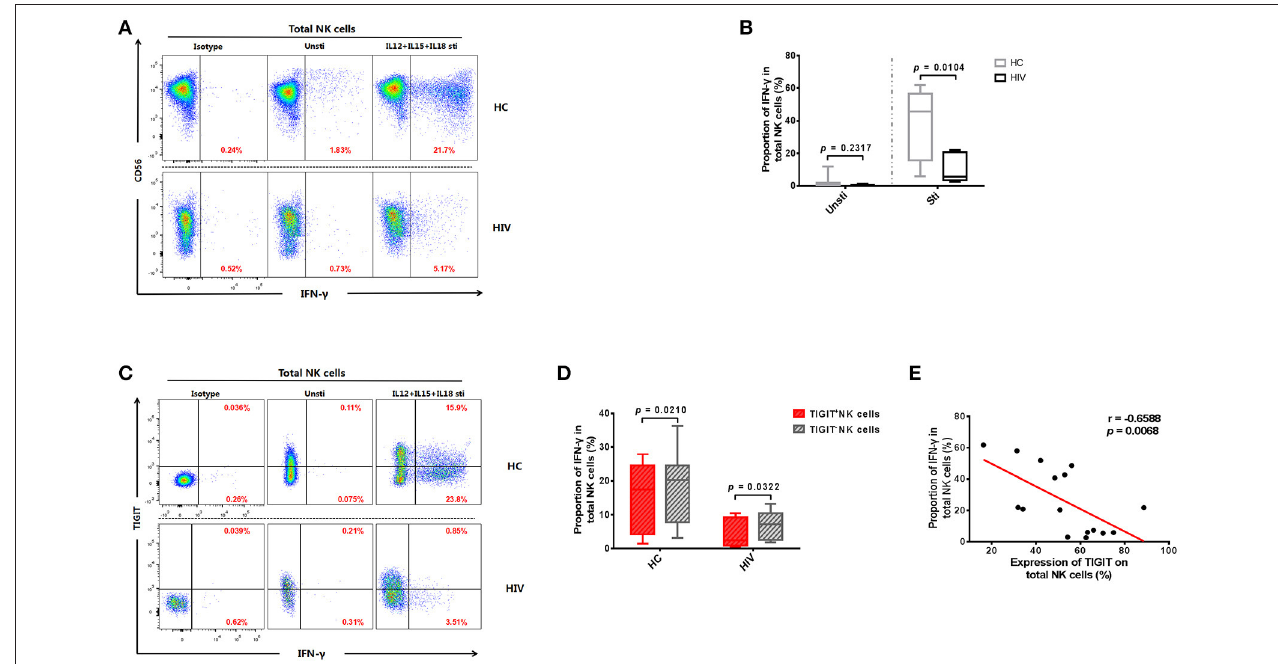
FIGURE 2 | Expression of TIGIT limits the production of IFN- γ by NK cells. (A) A representative flow cytometry plot showing the different percentages of IFN- γ producing NK cells after stimulation with rIL-12 + rIL-15 + rIL-18 for 24h in HC and HIV-infected individuals. The IFN- γ expression was gated according to an isotype control. (B) Comparison of the function of NK cells from HIV-infected ( n = 8) and HC ( n = 8) groups, based on their IFN- γ production on stimulation with rIL-12 + rIL-15 + rIL-18. (C) A representative flow cytometry plot showing the different percentages of IFN- γ producing TIGIT + and TIGIT − NK cells from HIV-infected individuals after stimulation with rIL-12 + rIL-15 + rIL-18 for 24h. (D) Paired comparisons of IFN- γ producing TIGIT + and TIGIT − NK cells from HIV-infected individuals after stimulation with rIL-12 + rIL-15 + rIL-18 for 24h (HIV: n = 11; HC: n = 12). (E) Analysis of the correlation between the percentage of TIGIT + NK cells and the percentages of IFN- γ producing NK cells from HIV-infected individuals ( n = 16). Mann-Whitney U tests were used for comparisons between two groups. The Wilcoxon matched-pairs signed-rank test was used for paired-group comparisons. The Spearman’s rank test was employed for correlation analyses. p < 0.05 was considered